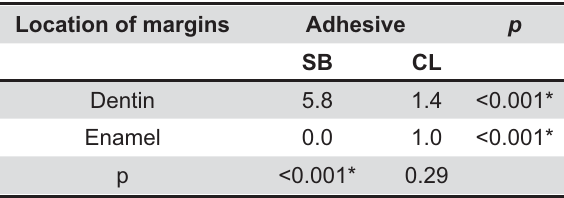
Table 1- Medians of gap measurements (in μm)